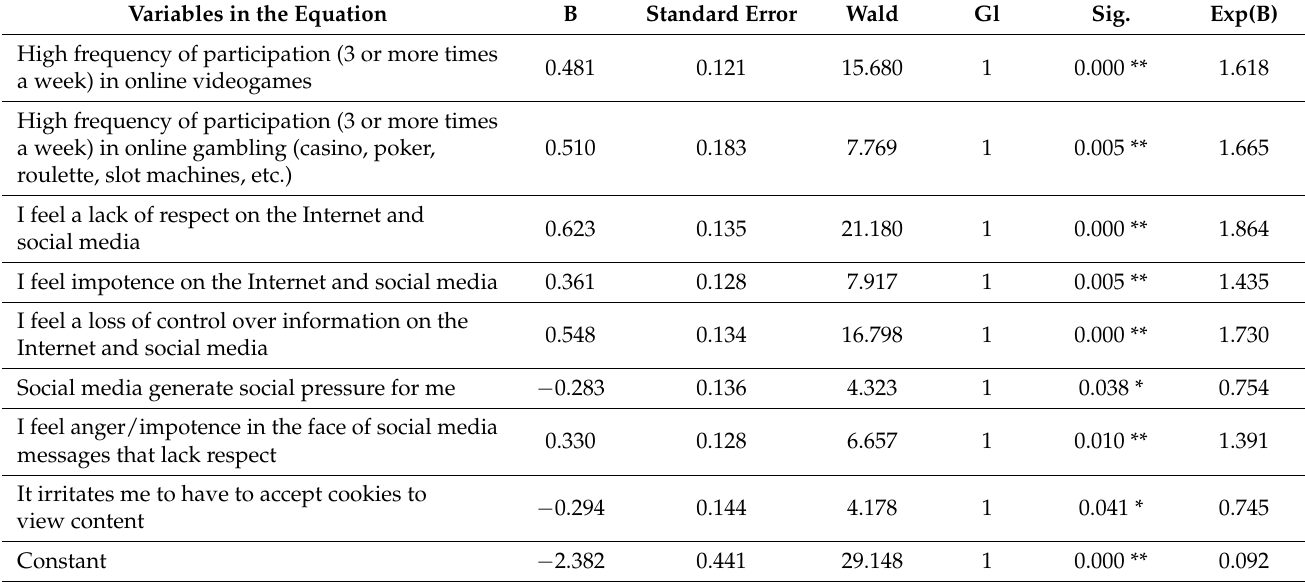
Table 2. Logistic regression model on the probability of perceiving risk or danger in online